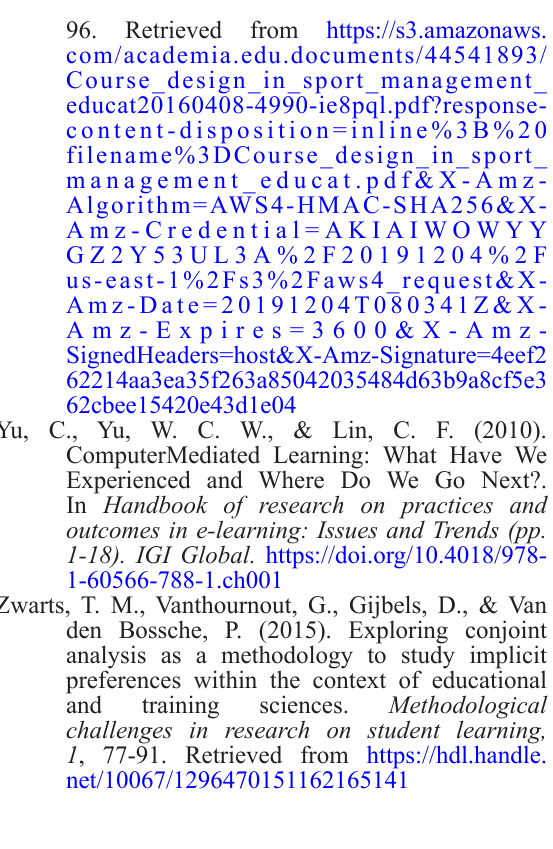
Algorithm=AWS4-HMAC-SHA256&X- A m z - C r e d e n t i a l = A K I A I W O W Y